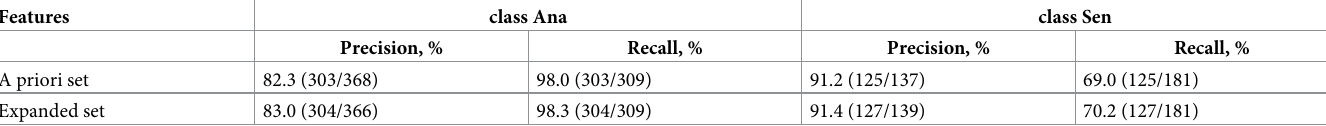
Table 3. Classification model performance in ML models with an abridged (known a priori) and expanded sets of features, each optimized to include only relevant features. Both models employed ordinal regression and were trained with Gradient Boosting for peanut allergy classification into reaction severity classes. Class Tol is not present in the input